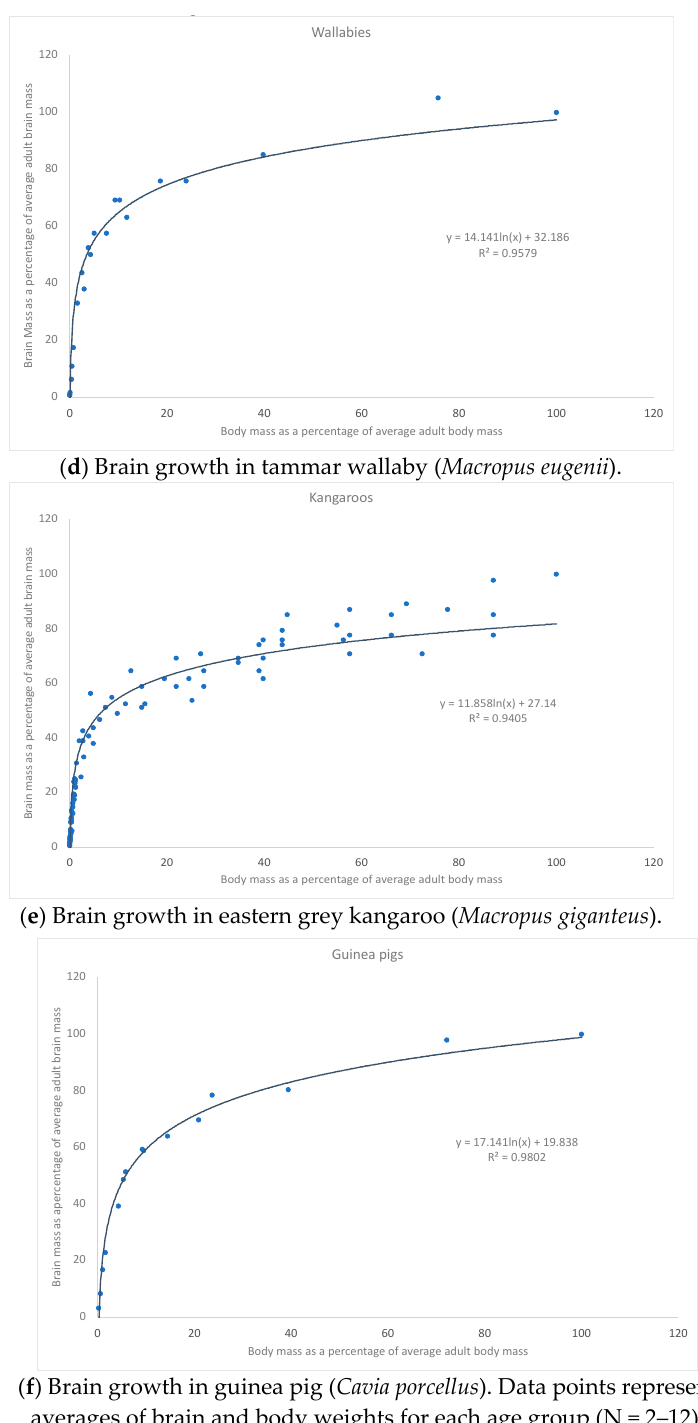
( c ) Brain growth in koala ( Phascolarctus cinereus ).